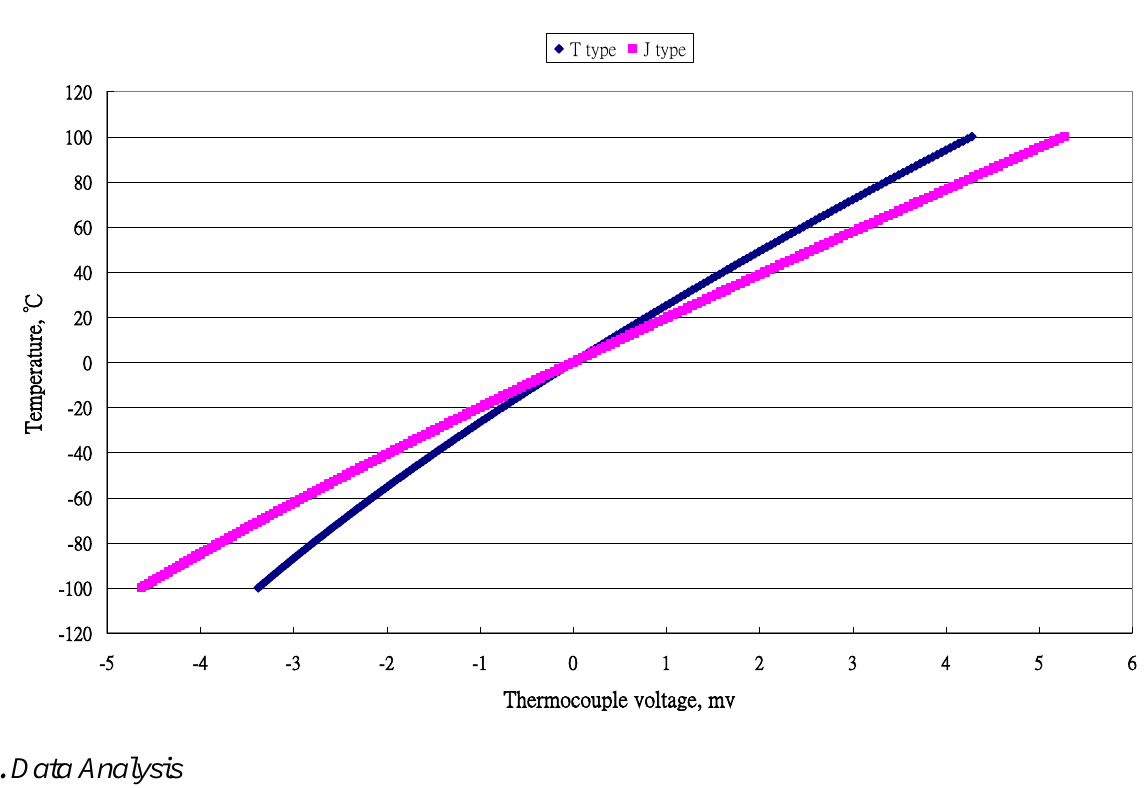
Figure 2. Distribution of temperature and output voltage of two types of thermocouples with temperature (−100 to 100 °C)